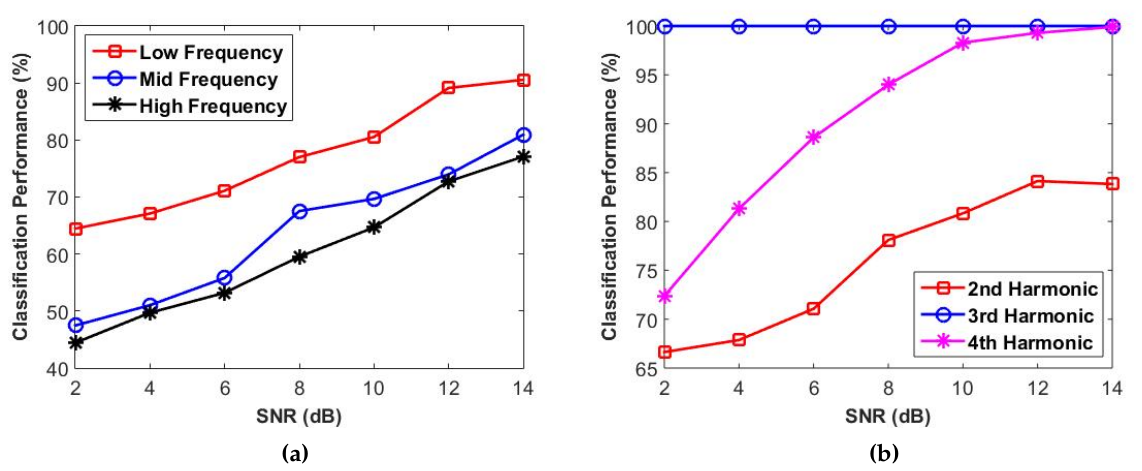
Figure 17. Classification performance of the harmonics in Fourier feature space for varying SNR values.